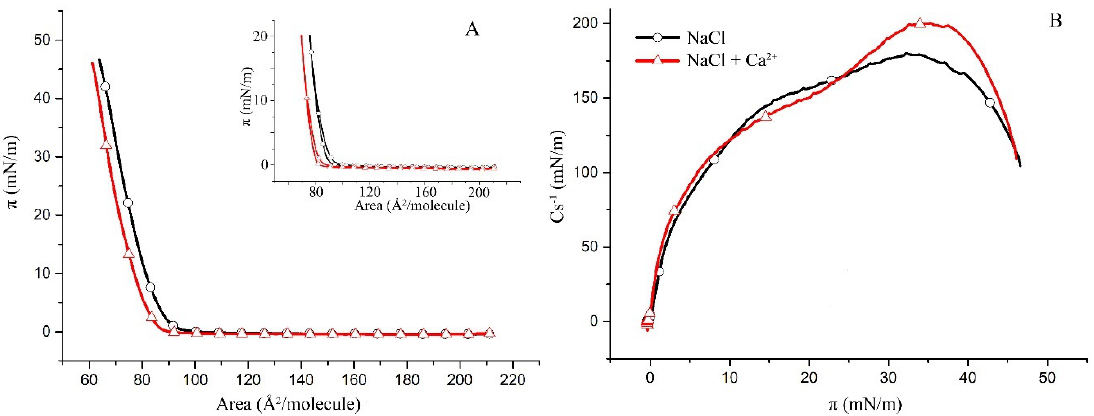
Figure 2. ( A ) Surface pressure/mean molecular area isotherms of the binary SM/Chol (1:1) monolay- ers in a subphase of 150 mM NaCl (black) and in 150 mM NaCl supplemented with 0.5 µM CaCl 2 (red) at 35 ± 2 °C (inset: π /A hysteresis cycles of compression–decompression); ( B ) surface compress- ibility moduli C s − 1 derived from the isotherms in ( A ) as a function of surface pressure.